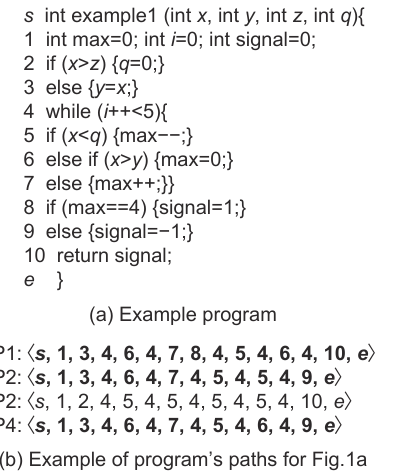
Fig. 1b. Paths P1, P2, and P4 (highlighted in bold) in